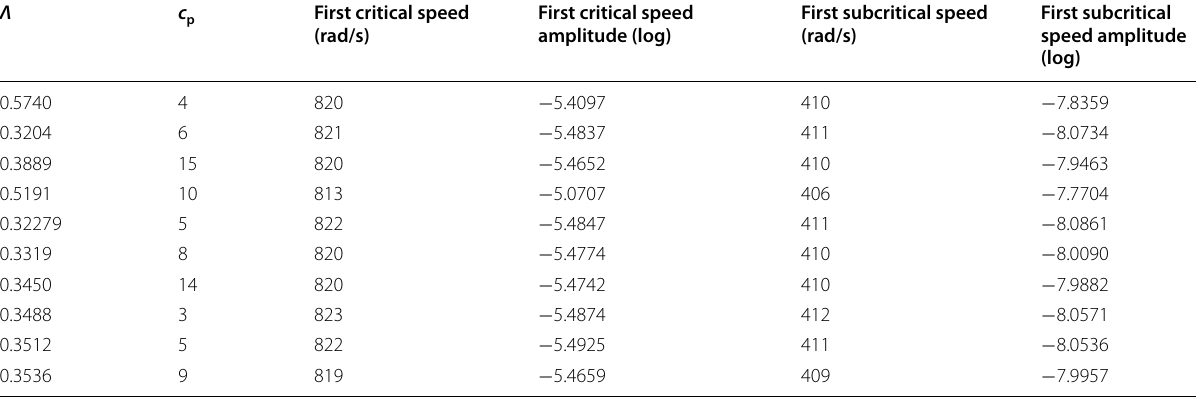
Table 3 Part of the data used to validate and test the RBF